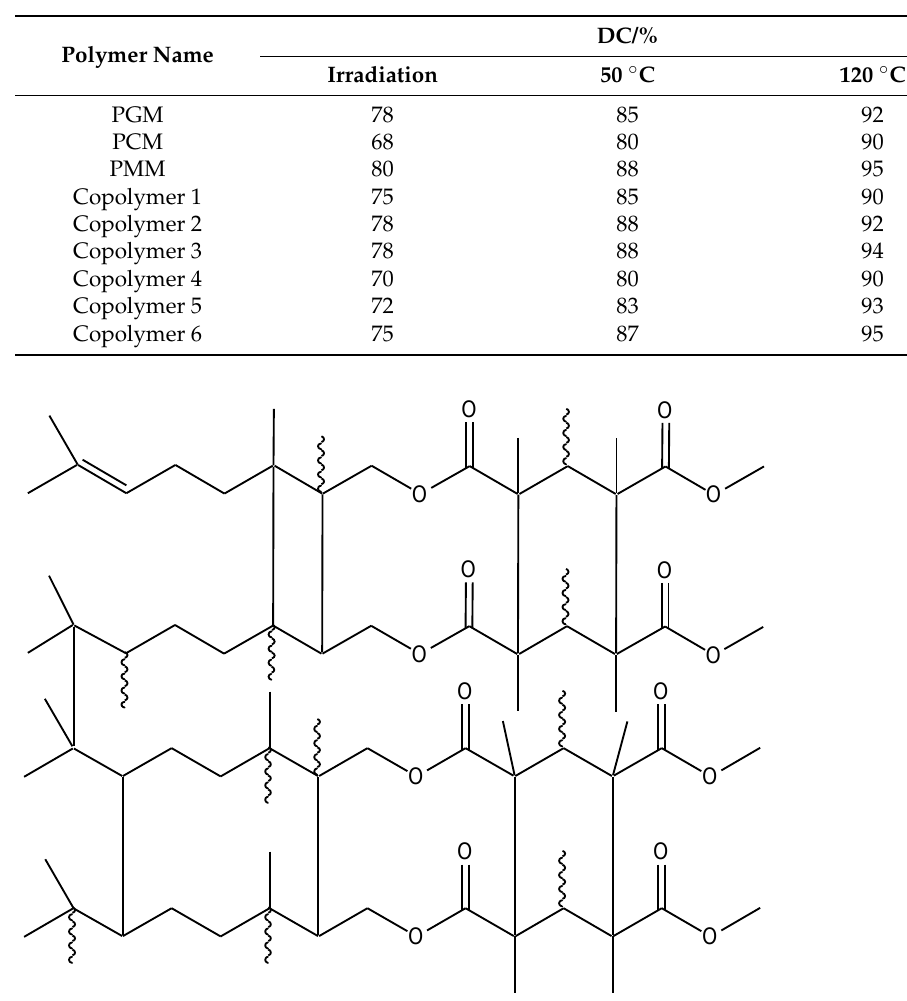
Figure 2. ATR-FTIR spectra for copolymers. Table 3. Conversion degree (DC) of double